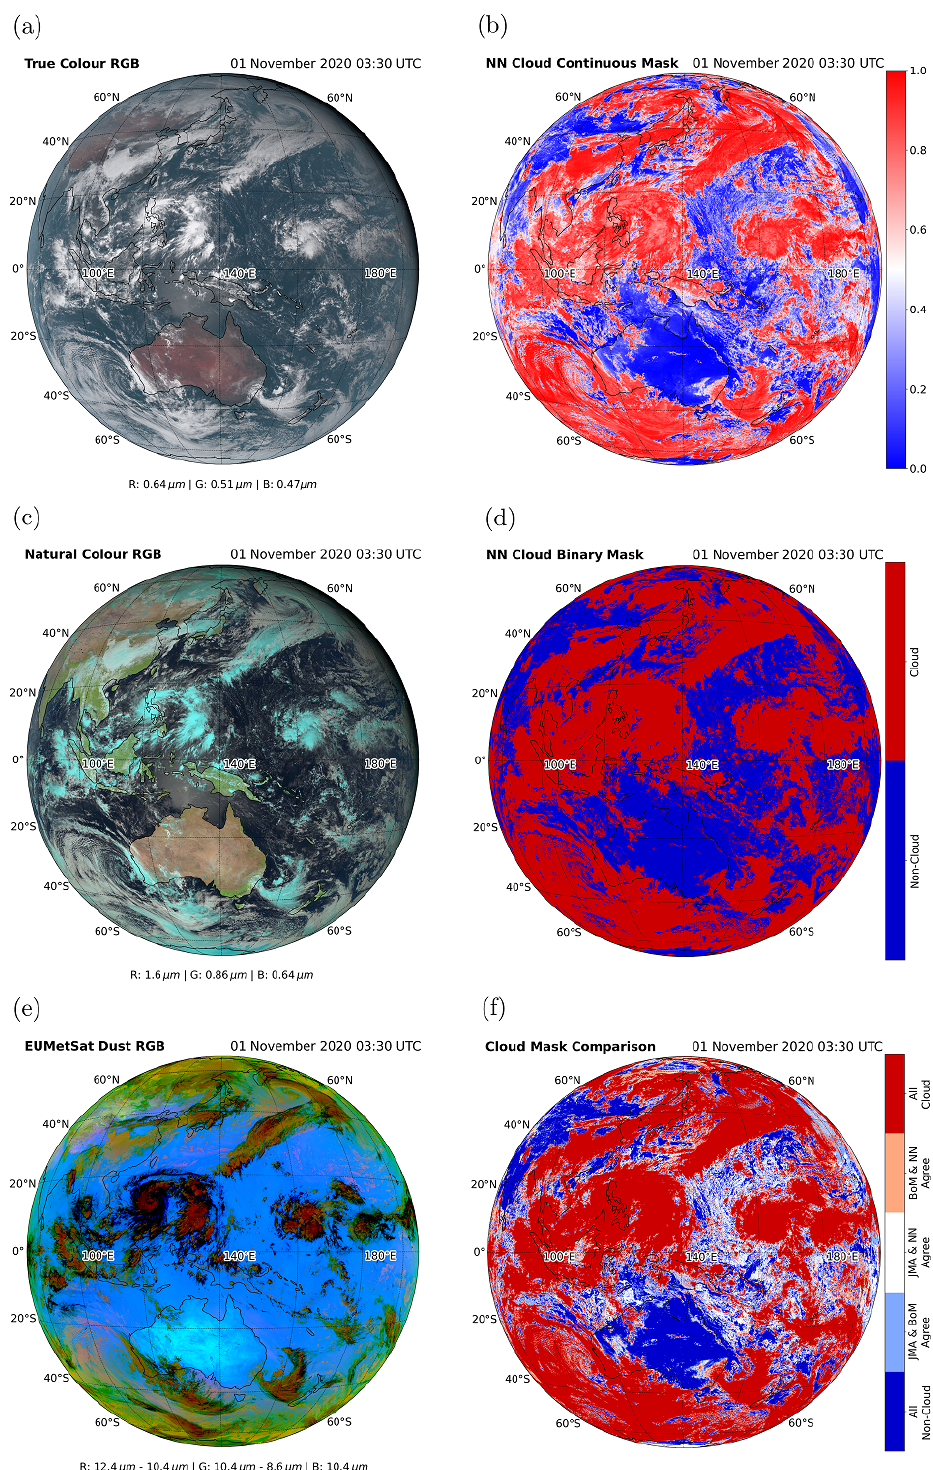
Figure 7. A full-disk AHI scene for 1 November 2020 at 03:30UTC. A total of three RGB false-colour composites of the scene are presented in the left-hand column, showing (a) true-colour, (c) natural-colour and (e) dust RGBs. The top, middle and bottom panels of the right-hand column show (b) the NN continuous cloud mask, (d) NN binary cloud mask and (f) a comparison of the three binary masks for the